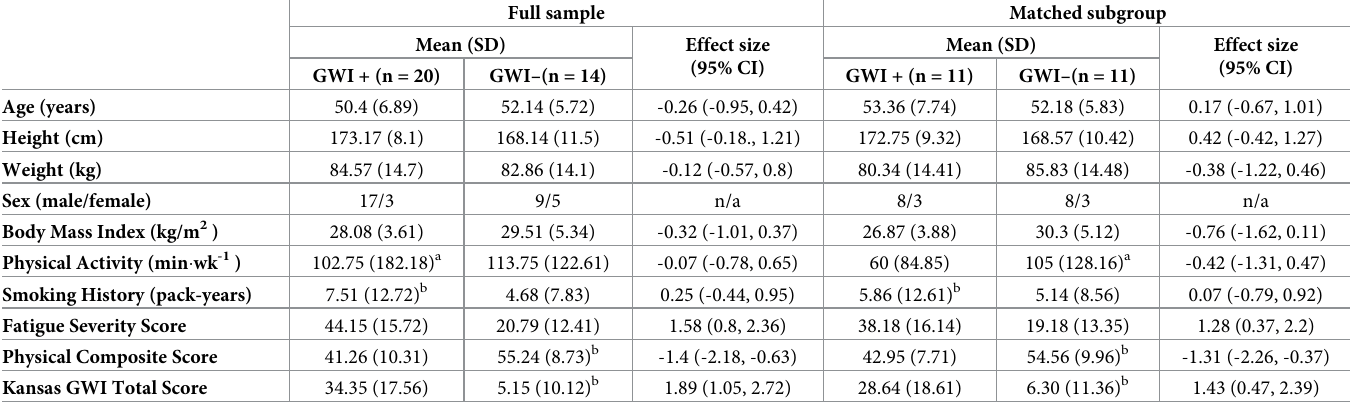
Table 1. Comparison of mean (SD) demographics and self-reported physical and mental health between participants with positive and negative Gulf War Illness diagnoses.